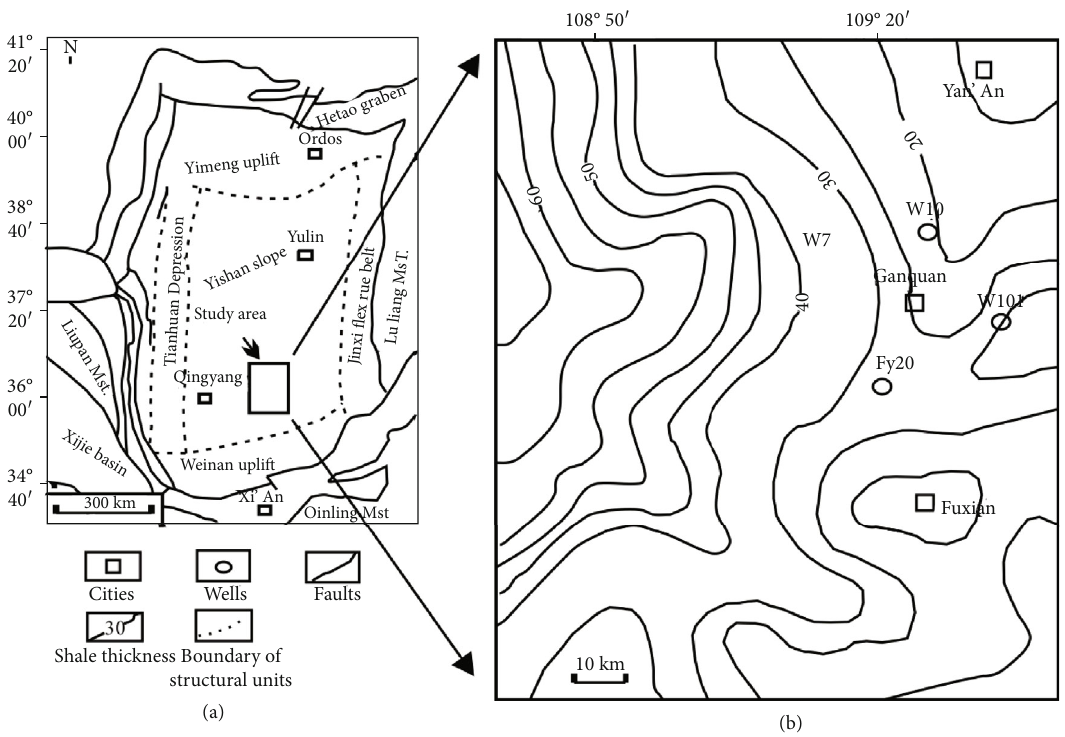
Figure 1: Regional tectonic pro fi le and the location of the sampling well in the Ordos Basin,